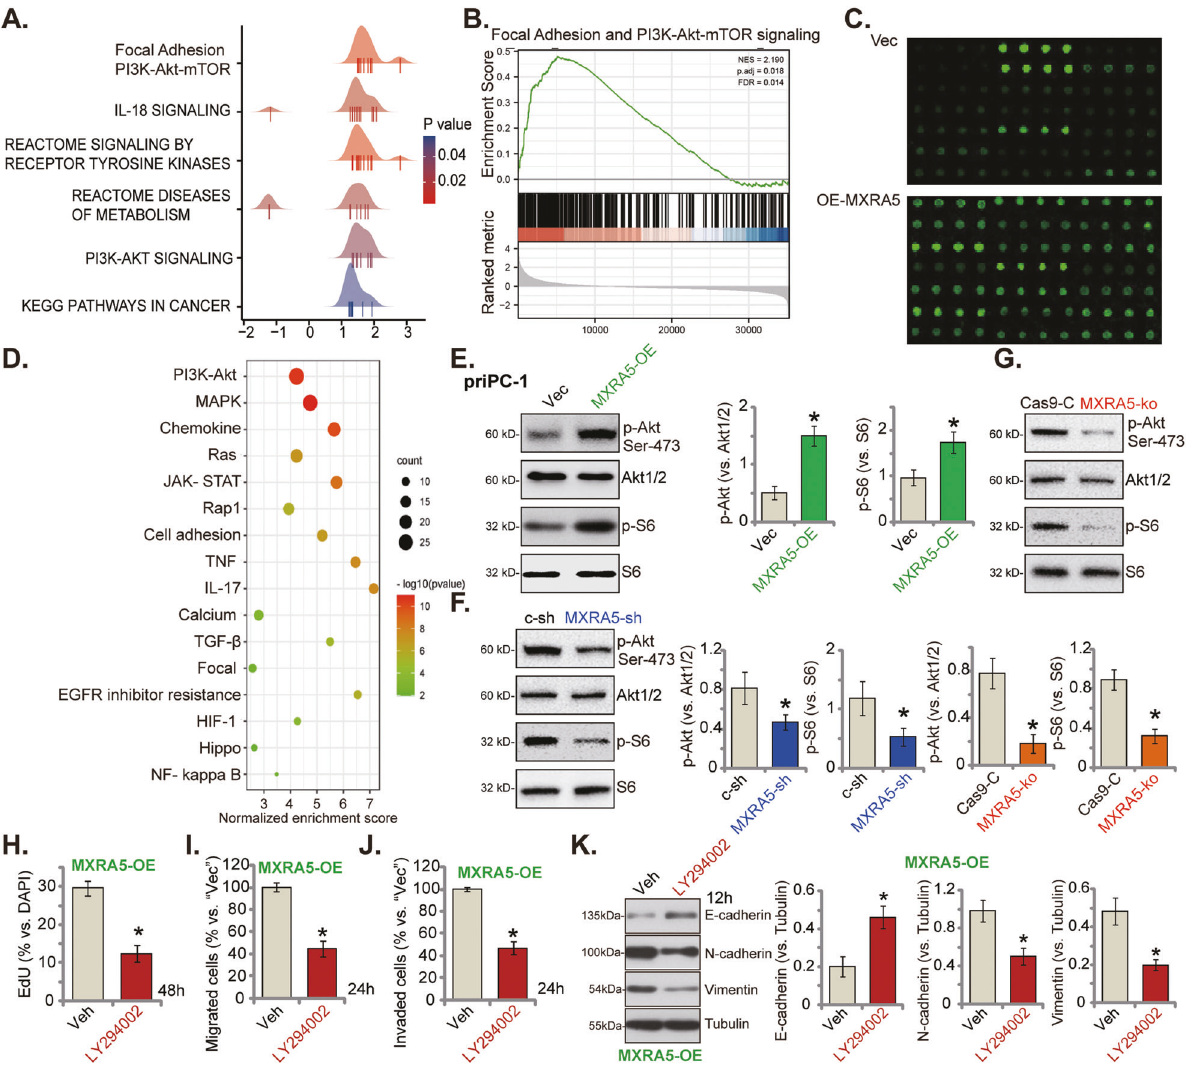
Protein chip study of differentially expressed proteins (DEPs) in priPC-1 primary human pancreatic cancer cells with the lentiviral MXRA5 overexpression construct ( “ MXRA5-OE ” ) or the corresponding vector ( “ Vec ” ) ( C ); KEGG pathway analysis on the MXRA5-associated DEPs was shown ( D ). Puromycin-selected priPC-1 cells with MXRA5-OE, Vec, MXRA5-sh-S1 ( “ MXRA5-sh ” ), the scramble control shRNA ( “ c-sh ” ), the sgRNA- CRISPR/dCas-9 MXRA5-KO lentiviral construct ( “ MXRA5-ko ” ) or Cas9 control construct ( “ Cas9-C ” ), were cultured, and expression of listed proteins was shown ( E - G ). The OE-MXRA5 priPC-1 cells were treated with the PI3K-Akt-mTOR pan inhibitor LY294002 (5 μ M) or the vehicle control (0.1% DMSO, “ Veh ” ) for indicated time periods, EdU incorporation ( H ), in vitro cell migration ( I ) and invasion ( J ) were tested, with results quanti fi ed; Expression of listed proteins was shown ( K ). Error bars stand for mean ± standard deviation (SD, n = 5). * P < 0.05 versus “ Vec ” / “ c-sh ” / “ Cas9-C ” cells or “ Veh ” treatment. Experiments in this fi gure were repeated fi ve